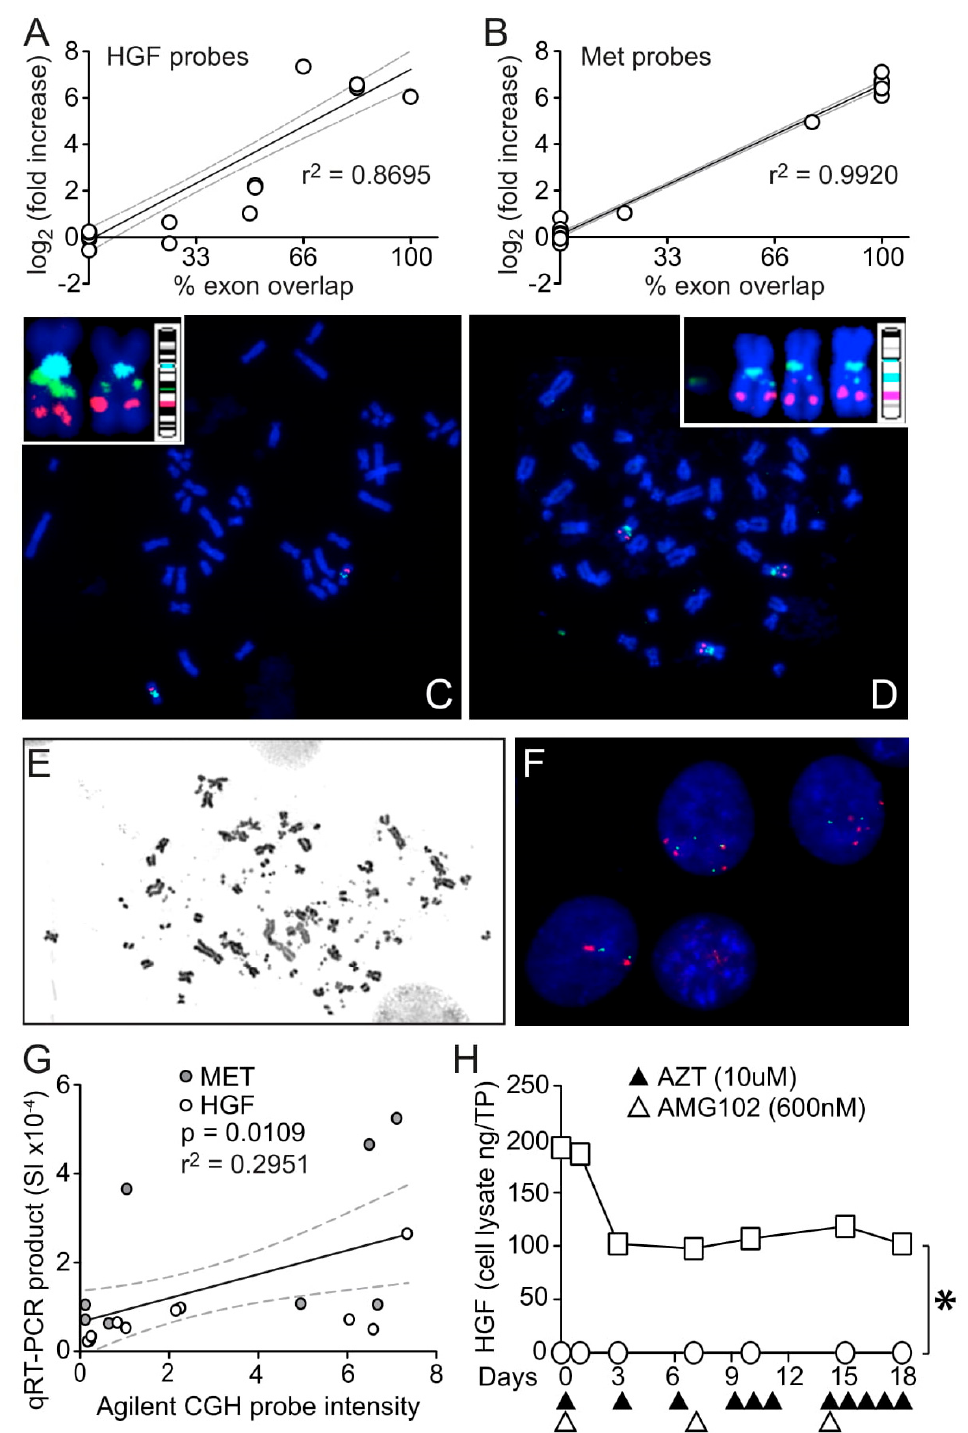
Figure 6. HGF and MET gene CGH array probe analysis, FISH, qRT-PCR and HGF protein reduction by AZT indicate that amplification involved reverse transcription. Scatter plot of intensity scores ( y -axis, log 2 (fold increase)) from individual CGH array probes for HGF ( A ) or MET ( B ) vs. percent overlap between probe sequence and matching complementary gene exon sequence ( x -axis). Linear regression analysis lines (black), 95% confidence intervals (dashed gray lines) and r 2 values are shown. FISH analysis of U87 MG ( C ) and U87 MG/HNR ( D ); MET probes are red, HGF probes are green and centromeric probes are cyan. Insets in each panel show copies of chromosome 7 adjacent to ideograms of probe locations. Inset for U87 MG/HNR ( D ) shows double-minute